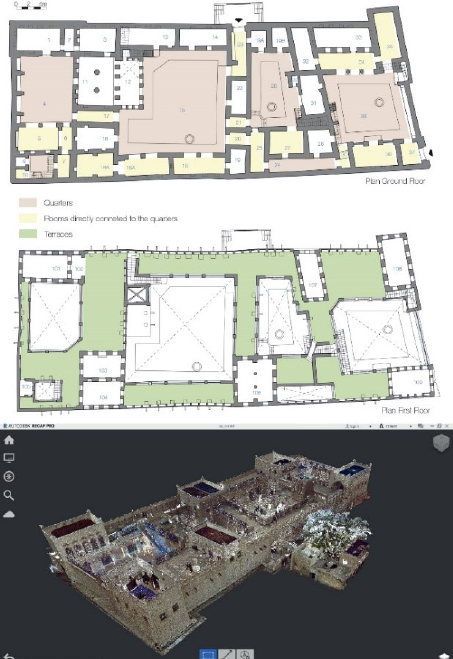
Figure 2. The point cloud project of The house of Shaykh Isa bin Ali Al-Khalifa and the as-found drawings produced during the